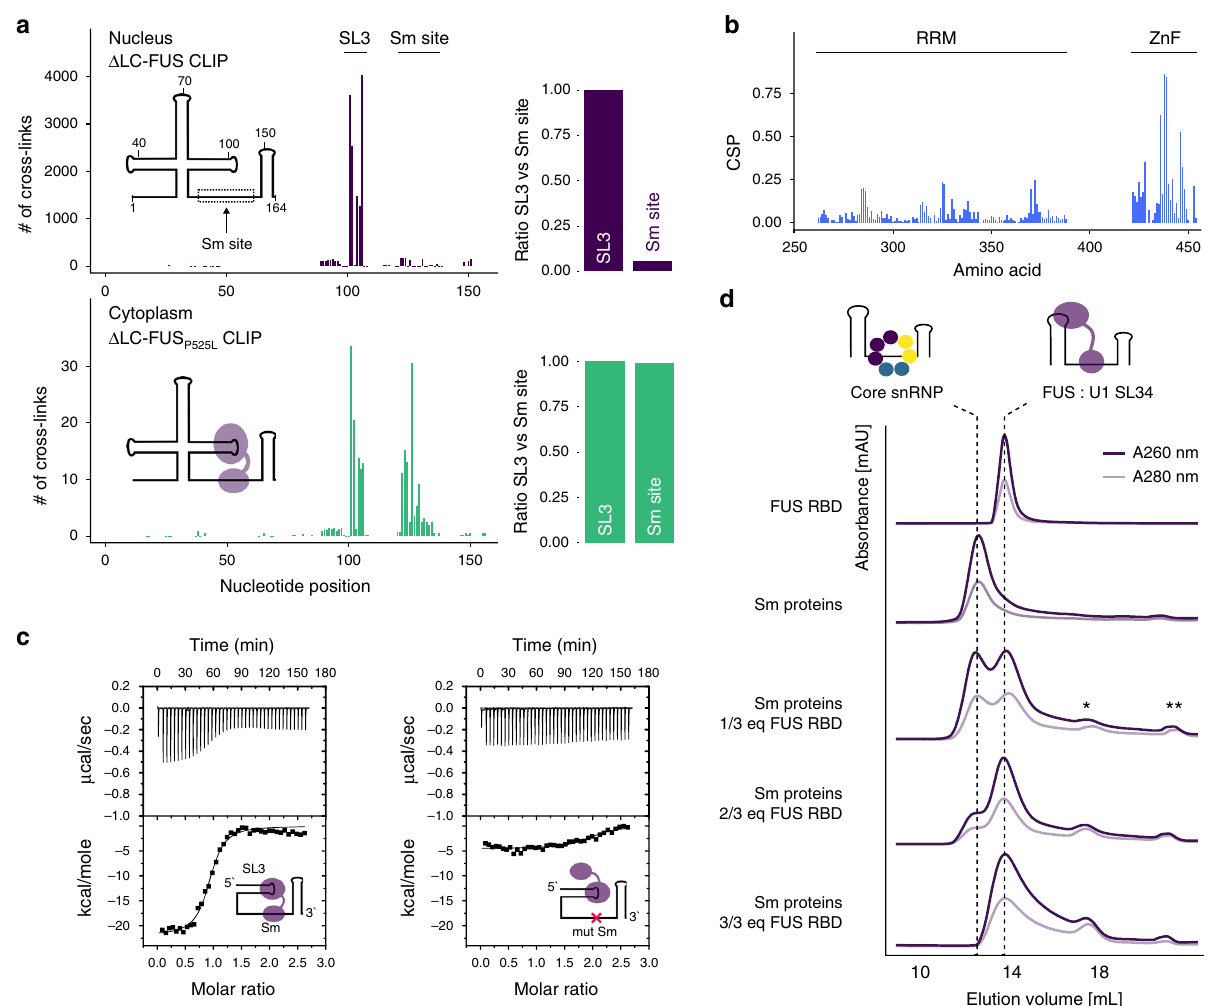
Fig. 4 ALS-associated FUS cross-links to the Sm site of pre-U1 snRNA. a Number of cross-links along U1 snRNA nucleotide sequence for the nuclear and cytoplasmic Δ LC-FUS constructs. The bar plots display the ratio of cross-links in the Sm site (nucleotides 123 – 135) relative to SL3 (nucleotides 99 – 110). b Bar plot showing the chemical shift differences in FUS – RBD upon addition of U1 SL34 RNA. n = 3. c ITC measurements of FUS with WT SL34 and mutSm SL34 RNA. n = 3. d Core snRNPs were assembled in vitro in the presence of the increasing amount of FUS. The resulting complexes were separated by analytical size-exclusion chromatography. Absorbance at 260 and 280 nm is shown. *unbound FUS – RBD, **unbound Sm proteins. n =